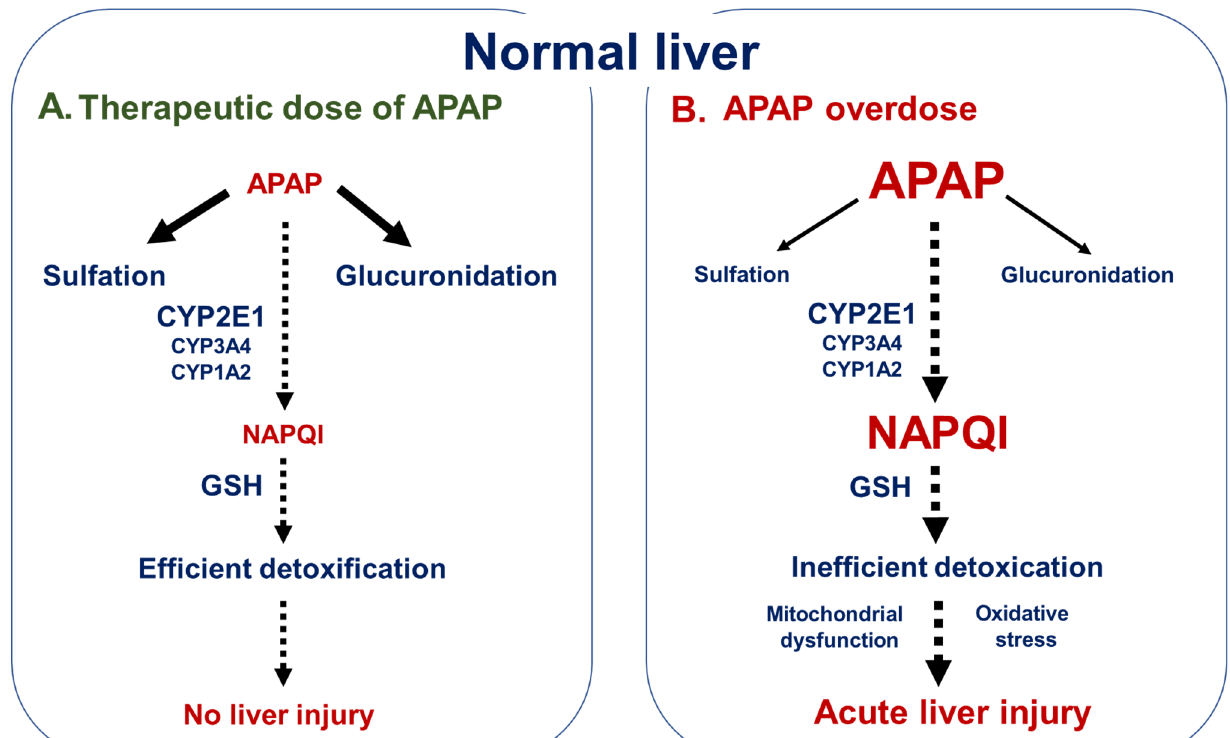
Figure 1. Biotransformation and toxicity of APAP in normal liver. ( A ). For therapeutic dose, APAP is mainly detoxified through sulfation and glucuronidation, while a small proportion is metabolized to N-acetyl- p -benzoquinone imine (NAPQI) via the cytochrome P450 2E1 (CYP2E1) and to a lesser extent CYP3A4 and CYP1A2. In normal liver, the low amounts of NAPQI are efficiently detoxified by glutathione (GSH), a major antioxidant molecule present in different cellular compartments in- cluding mitochondria. ( B ). After APAP overdoses, the sulfation and glucuronidation pathways are overwhelmed and more APAP undergoes CYP-dependent oxidation to NAPQI. However, GSH con- centrations in hepatocytes are not sufficient to allow the efficient detoxification of NAPQI, which then induces major mitochondrial dysfunction, oxidative stress and acute liver injury. More information is provided in the